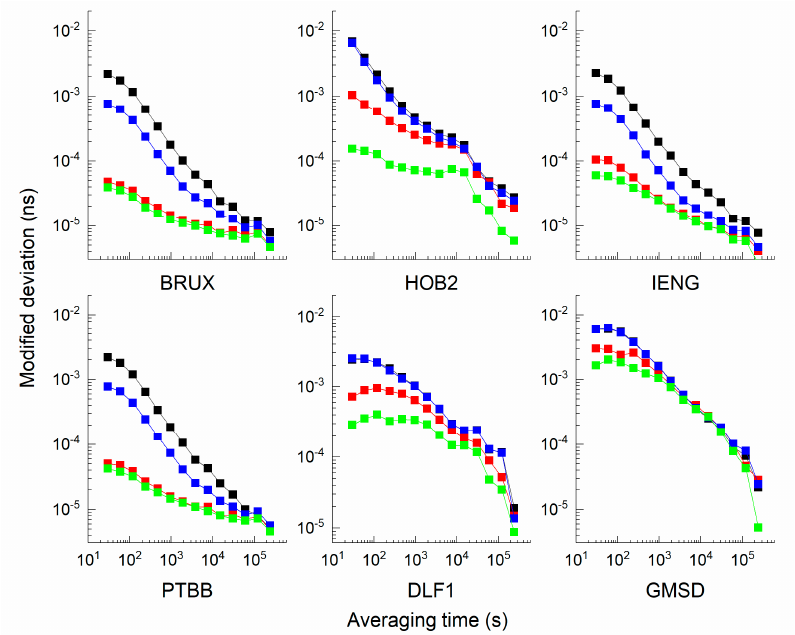
Figure 11. Comparison on modified deviation of six stations.